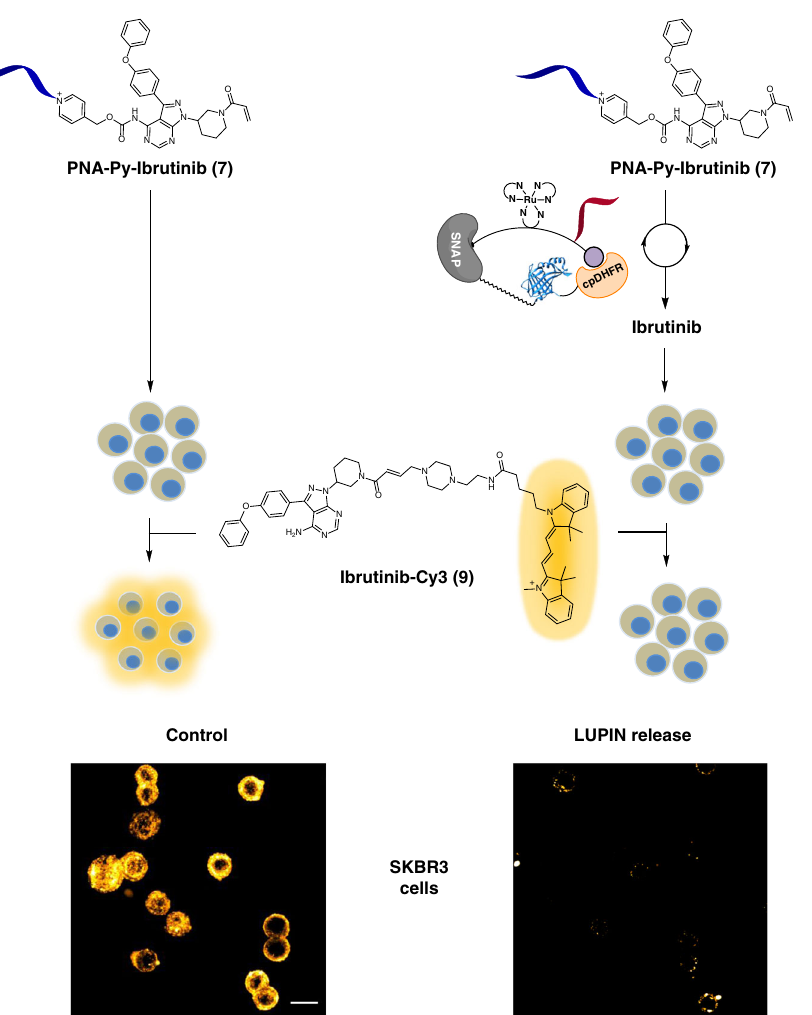
Fig. 4 LUPIN release of ibrutinib. Ibrutinib release by LUPIN was demonstrated by competition with ibrutinib-Cy3 ( 9 ) derivative in SKBR3 cells overexpressing ErbB2. SKBR3 cells were treated with either the prodrug alone ( 7 ) or prodrug ( 7 ) + LUPIN for 30 min; then the cells were treated with ibrutinib-Cy3 ( 9 ). The lower fl uorescence observed for the LUPIN-uncaged product population indicates that the ErbB2 was saturated with the uncaged prodrug. Conditions for LUPIN release: SNAP-NLuc-DHFR labeled with BG-(Ru)(PNA)-MTX ( 1 ) (10 nM), PNA-PyIbr ( 7 ) (5 µ M), sodium ascorbate (10 mM), furimazine (100 µ M), and Ibr-Cy3 ( 9 ) (50 nM). Scale bar: 20 µ